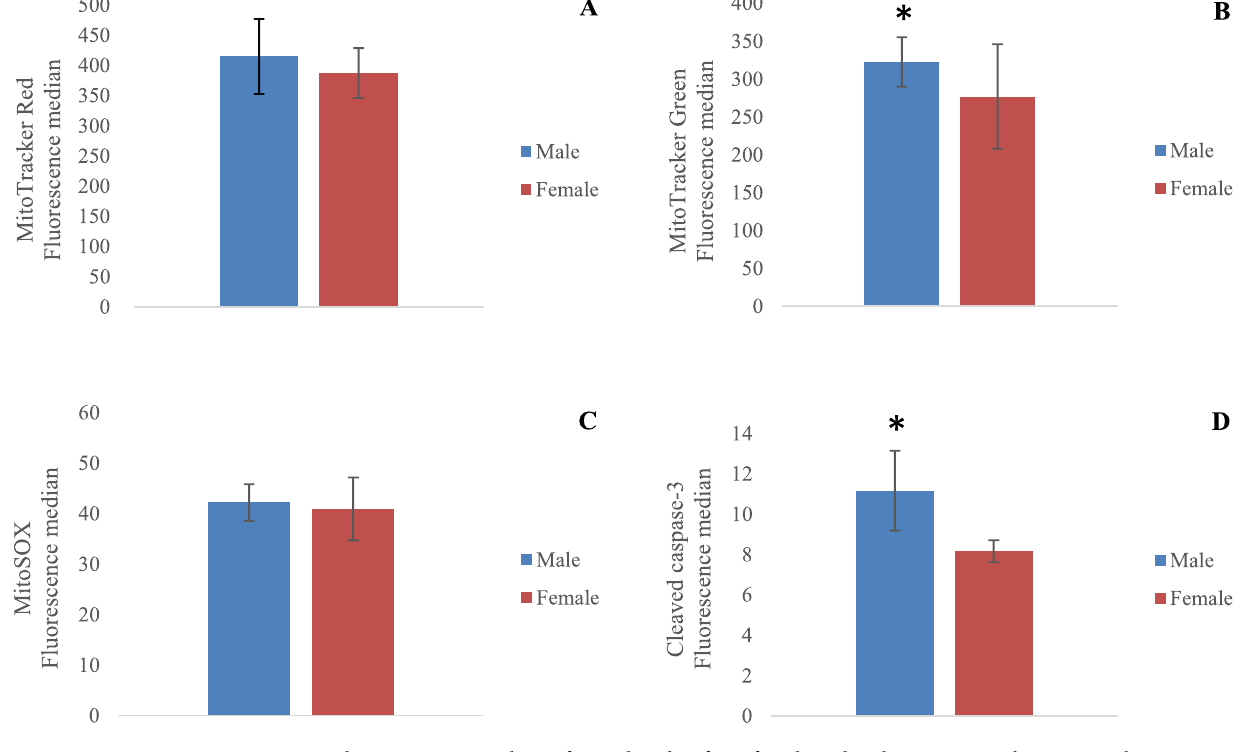
Figure 8. Flow cytometry analysis of mitochondria from female and male organotypic hippocampal slice cultures. Fluorescence median for mitochondrial membrane potential using MitoTracker Red ( A ), mitochondrial mass using MitoTracker Green ( B ), superoxide production using MitoSox ( C ) and cleaved caspase-3 ( D ). Significant differences between females (n = 5 biological replicates, each containing 3 slices) and males (n = 6 biological replicates, each containing 3 slices) were revealed by Student’s t test. *denotes p <